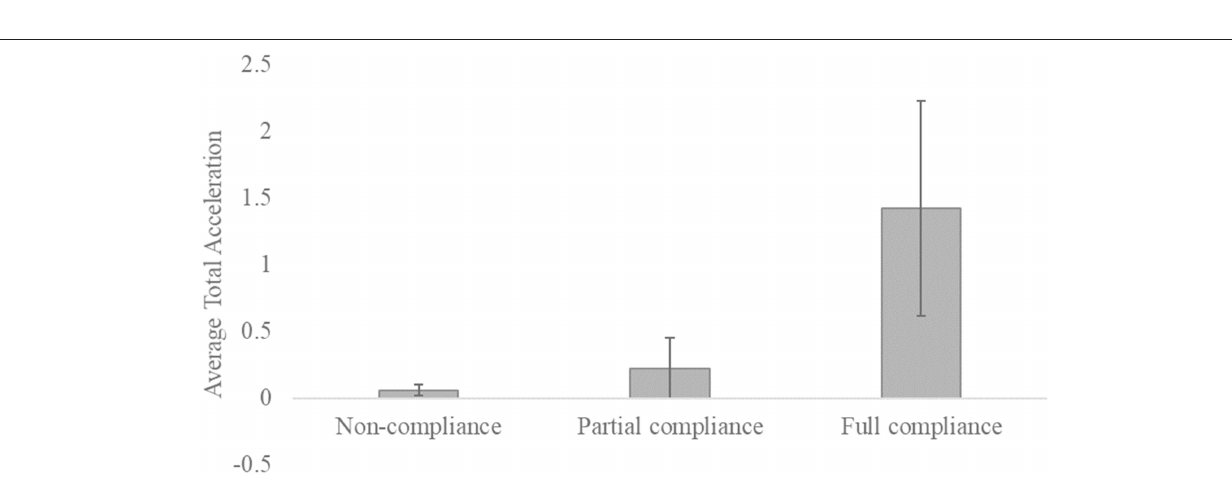
FIGURE 3 | Bar chart of the average total acceleration for the three compliance categories. The vertical lines within the bars represent the standard